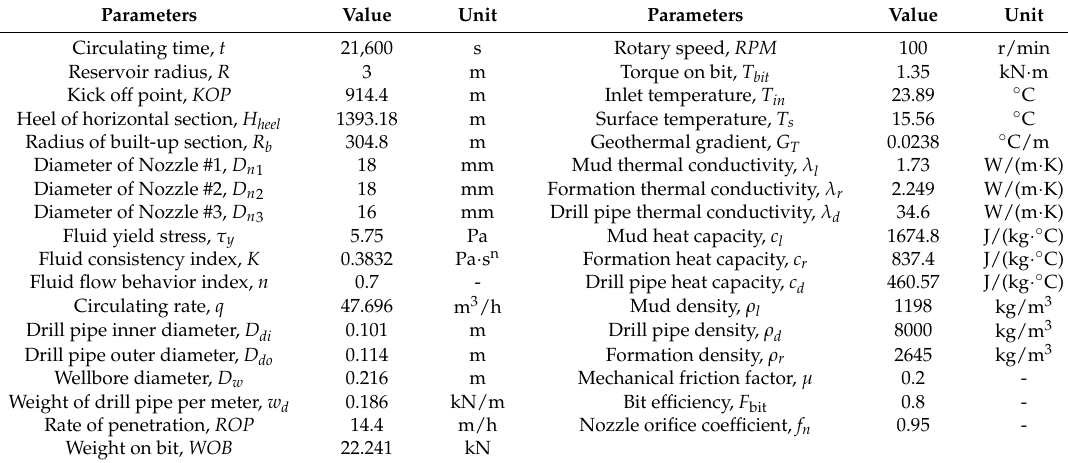
Figure A4. Flowchart of calculation procedure. Table A1. The input data for the case study in this